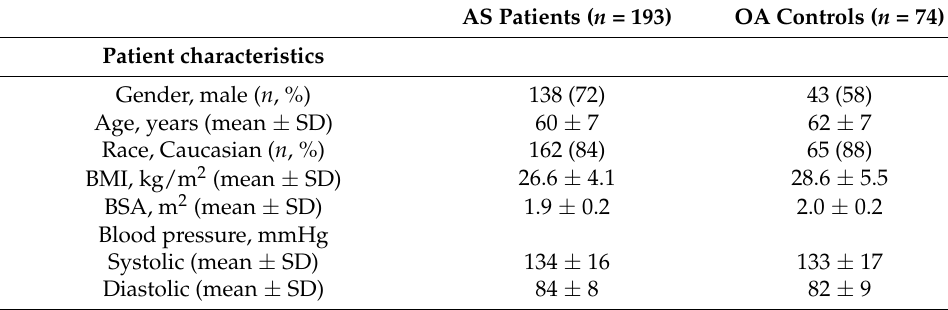
Table 1. Patient characteristics of AS and OA